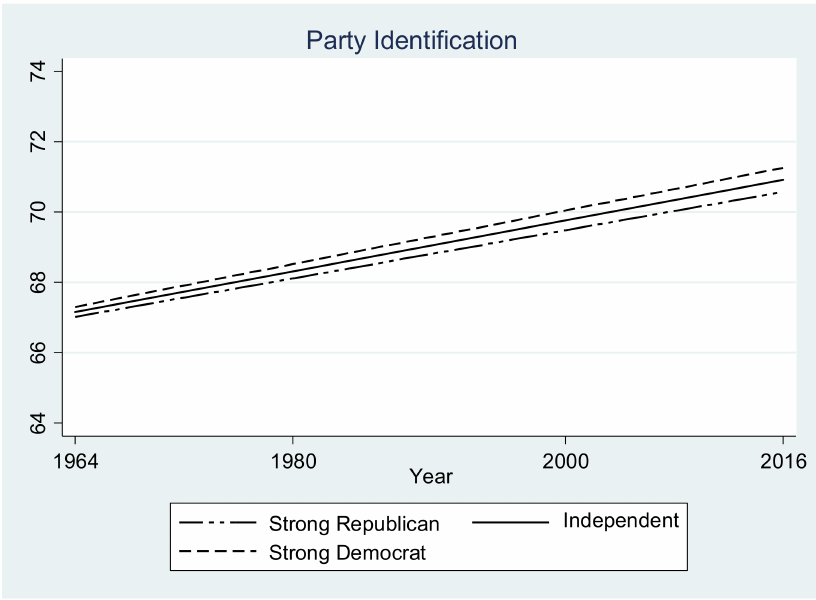
Figure 3. Impact of party identification on the Jewish feeling thermometer, 1964–2016. Based on results from Table 3. Source: American National Election Studies, 1964–2016.